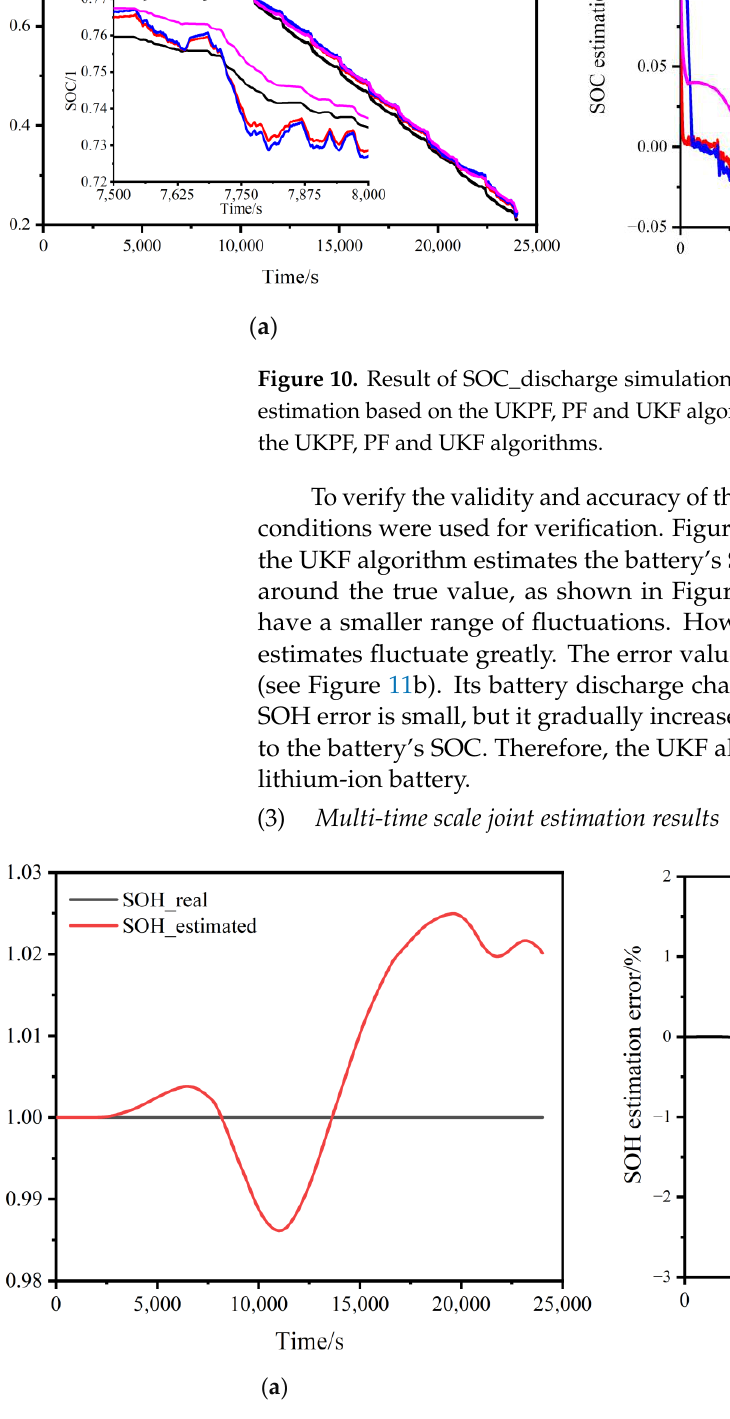
Figure 11. The result of SOH estimation: ( a ) SOH estimation; ( b ) SOH estimation error.